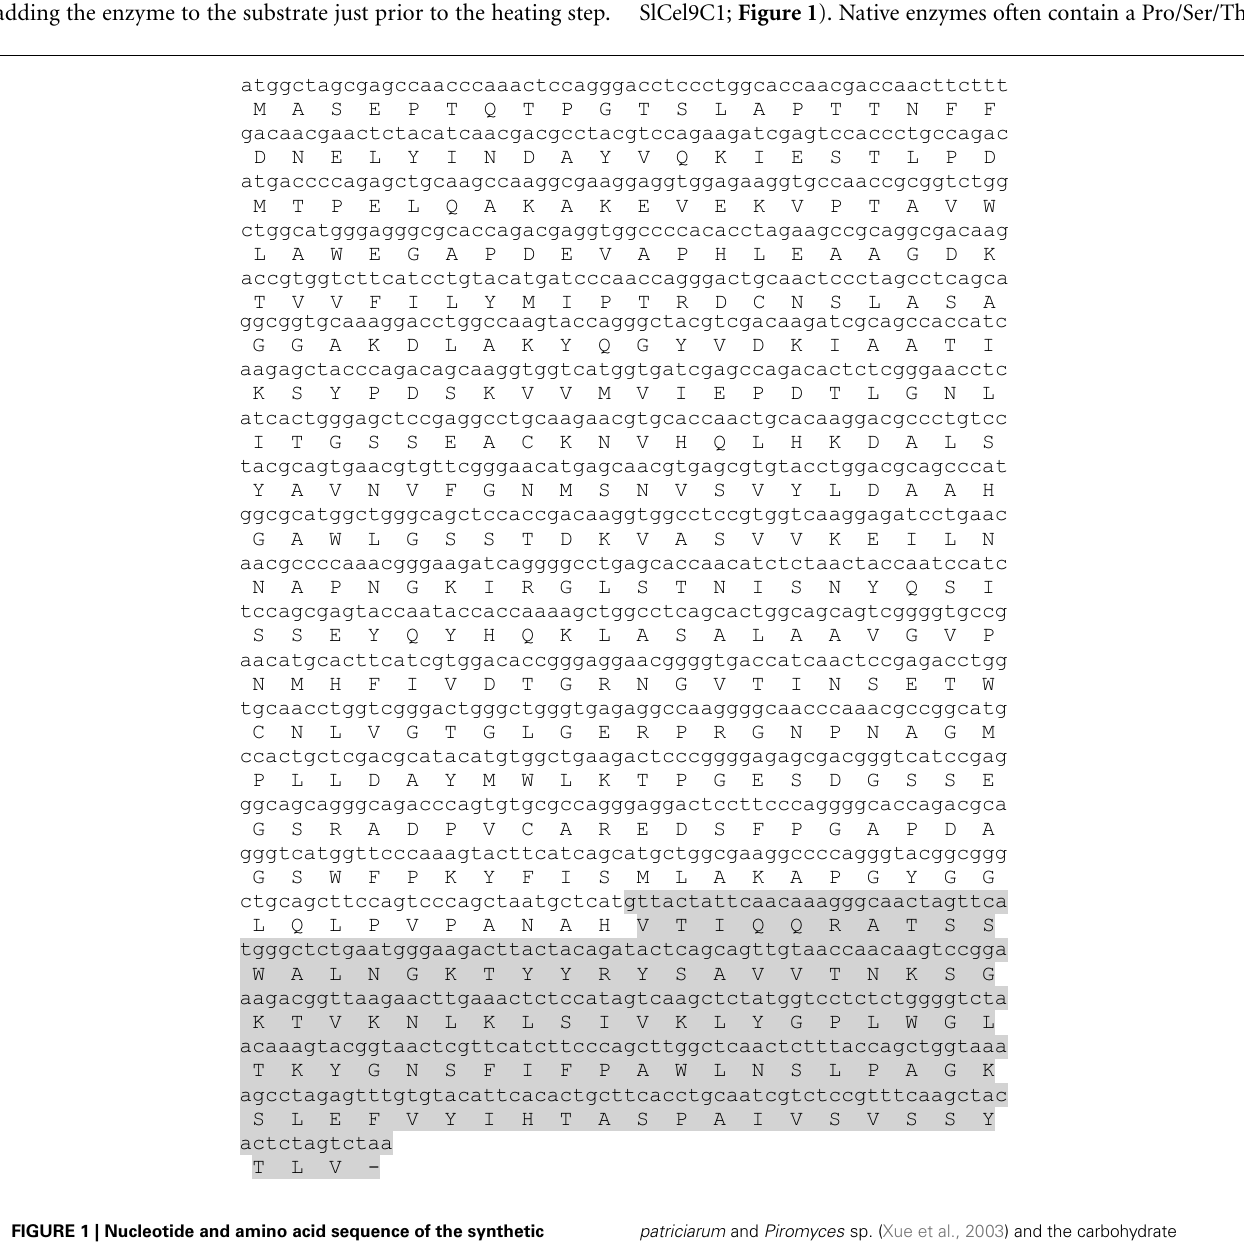
FIGURE 1 | Nucleotide and amino acid sequence of the synthetic glycosyl hydrolase. The synthetic glycosyl hydrolase CEL-HYB1 (unshaded) is a hybrid molecule with fragments from Neocallimastix